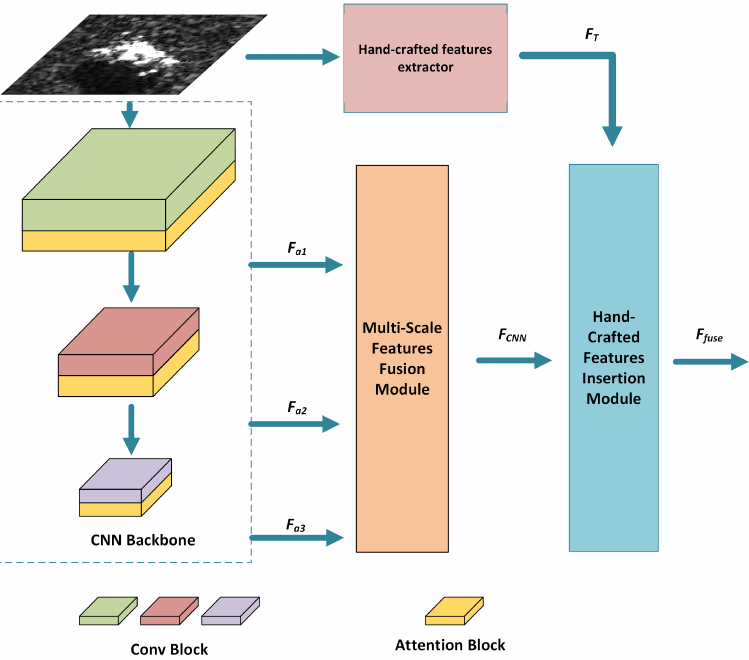
Figure 2. The overall architecture of the MFFN includes the MsFFM and the HcFIM. The channel- optimized features with different scales F a 1 , F a 2 , F a 3 are fed into the MsFFM to utilize the complemen- tary information from different layers. Afterwards, the fused feature F CNN is combined with the traditional hand-crafted features F T in the HcFIM. F fuse denotes the final output feature of the